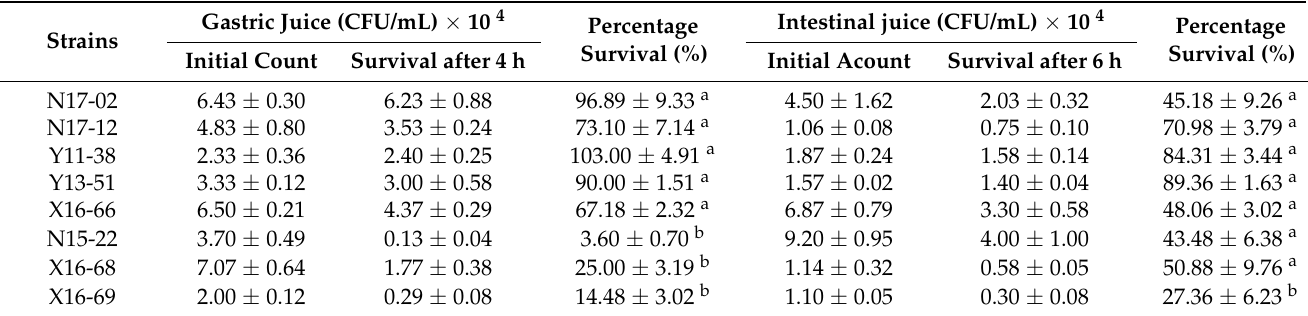
Table 3. Relative survival ratio of strains in artificial gastrointestinal juice.